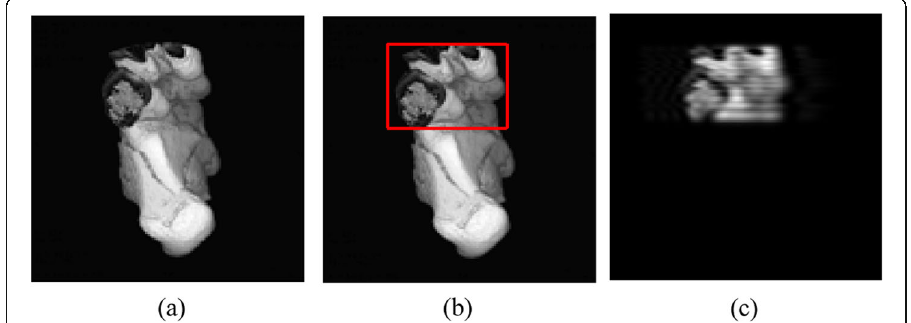
Fig. 7 CT image of the ankle: a original image, b lesion area (enclosed in the red-edged rectangle), and c local extraction